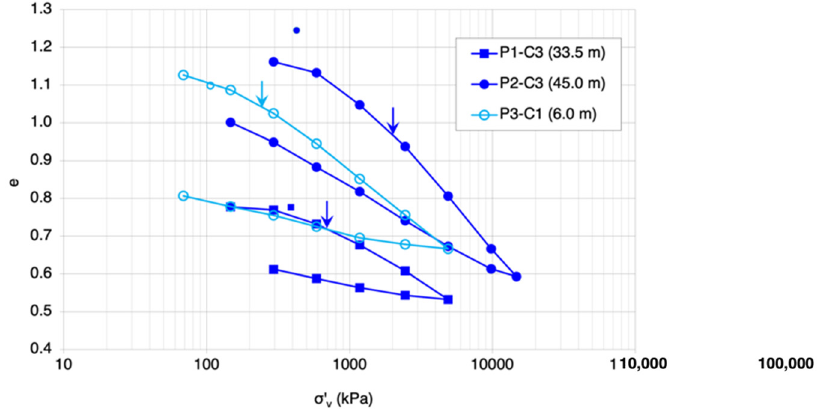
Figure 17. Sample oedometric compression curves for Faeto Flysch at Bovino; isolated points indicate the in situ state.